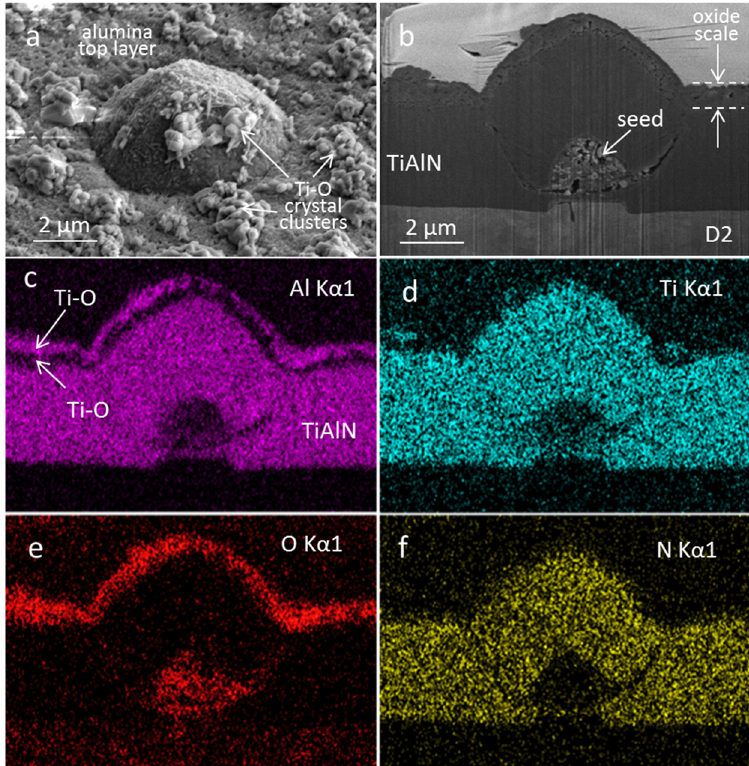
Figure 14. SEM images of nodular defect in sputter-deposited TiAlN hard coating oxidized at 850 °C for 60 min: ( a ) SEM image, ( b ) SEM image of the FIB cross-section of the same defect, and ( c – f ) corresponding elemental maps.